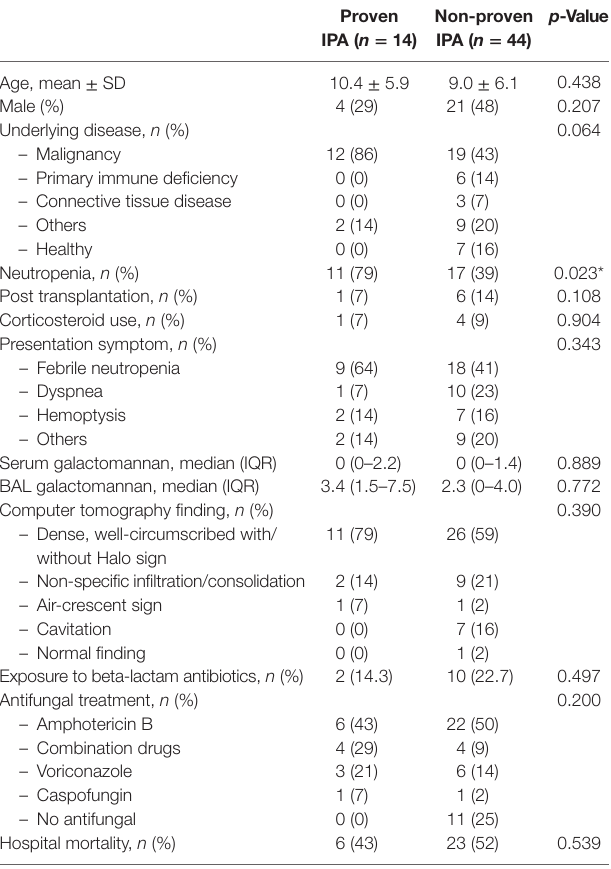
Table 2 | Baseline characteristics of the included patients. Table 3 | The sensitivity and specificity of each element in the EORTC/MSG